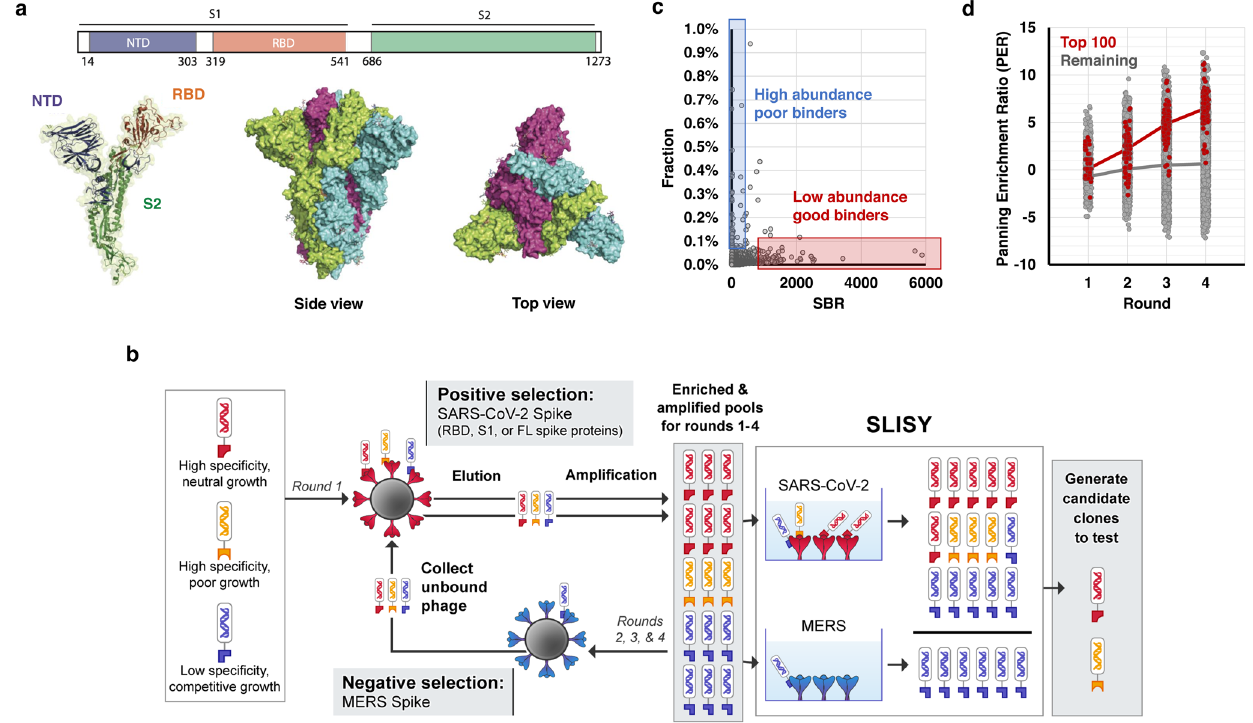
Fig. 2 | Applying SLISY to SARS-CoV-2 spike protein. a SARS-CoV-2 trimer. Scheme of the SARS-CoV-2 spike protein with ribbon and surface representations of the SARS-CoV-2 monomer showing the NTD, RBD and S2 domains (PDB ID “ 6VSB ” ). 26 b Schematic of biopanning and SLISY for SARS-CoV-2 speci fi c scFvs. c Low representation of clones with high SBR. Fraction of each clone within the entire pool after four roundsofpanning against the RBD is plotted against its SBR. Red box indicates clones that are likely good binders (high SBR) but at low